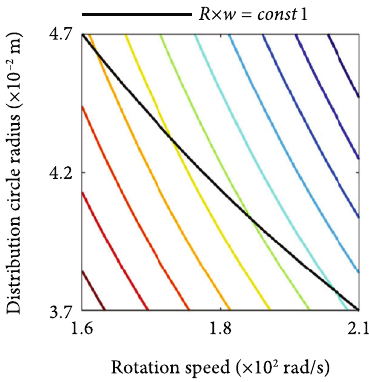
Figure 3: The projected contour plot of the variable pressure drop on the R ‐ w plane. term c 6